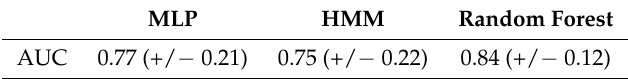
Table 5. Average Area Under the receiving operating characteristic Curve (AUC) for each eating classification model. MLP HMM